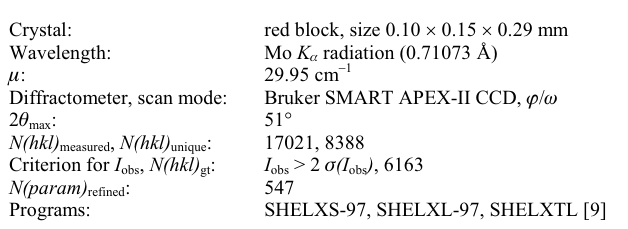
Table 1. Data collection and handling.